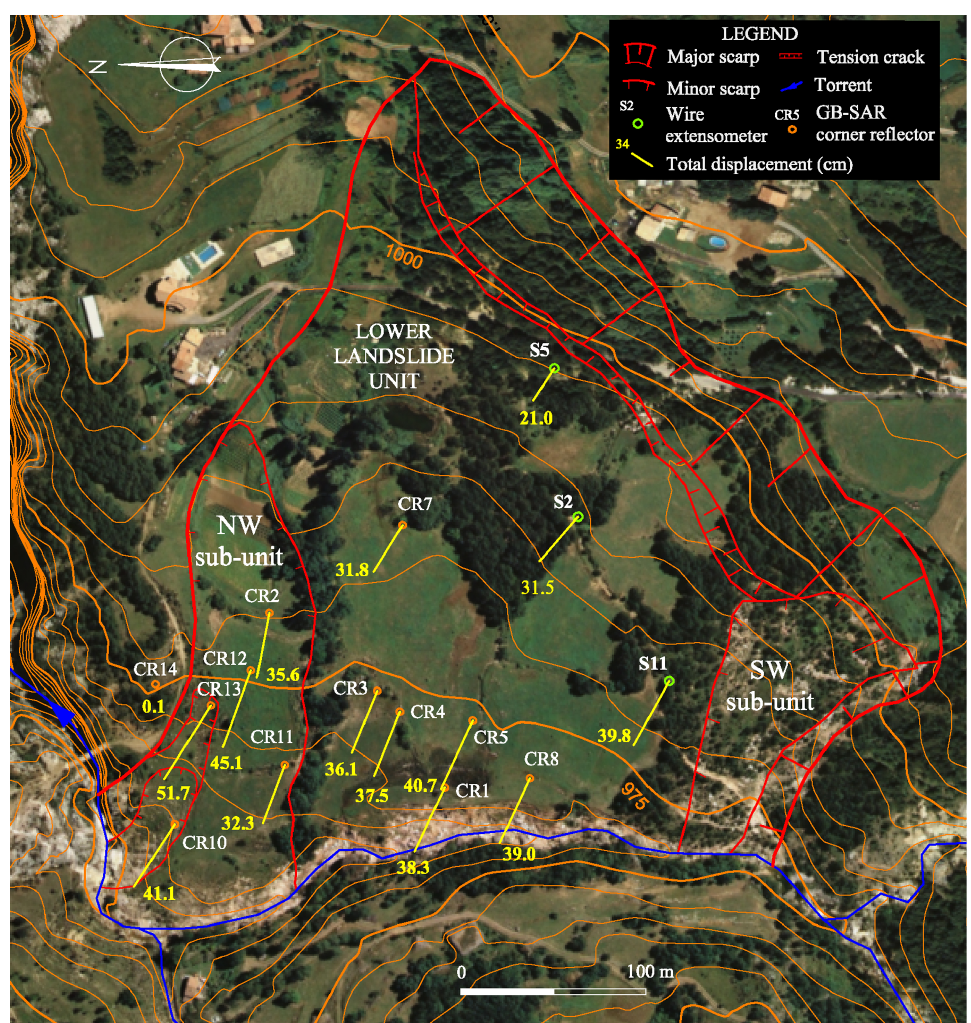
Fig. 12. Displacement field of the lower unit of the Vallcebre landslide reconstructed using GB-SAR CRs and borehole wire extensometers. Displacements are the total ones observed from 9 February 2010 to 11 November 2010. The CRs CR6, CR15, CR16, and CR17 are not included because they were installed after February